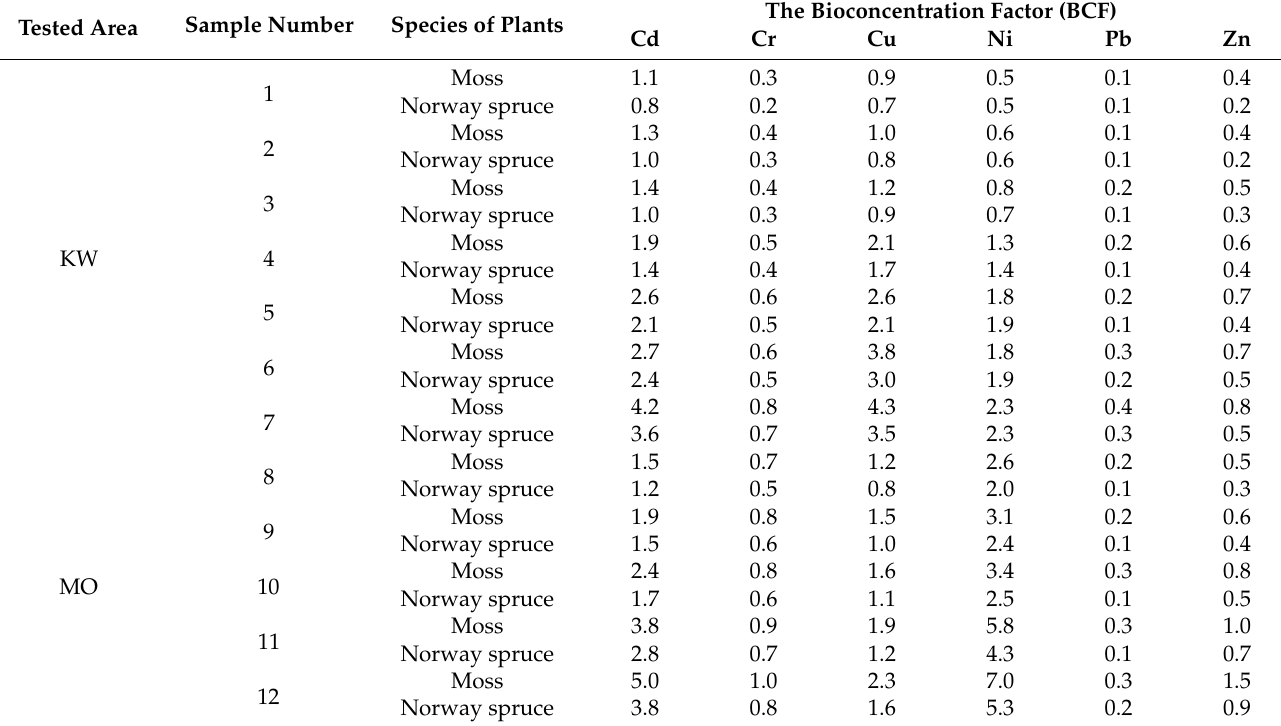
Table 6. The bioconcentration factor (BCF) for plants in the test areas (Kasprowy Wierch-KW and Morskie Oko-MO) in the Tatra National Park, Poland. Tested